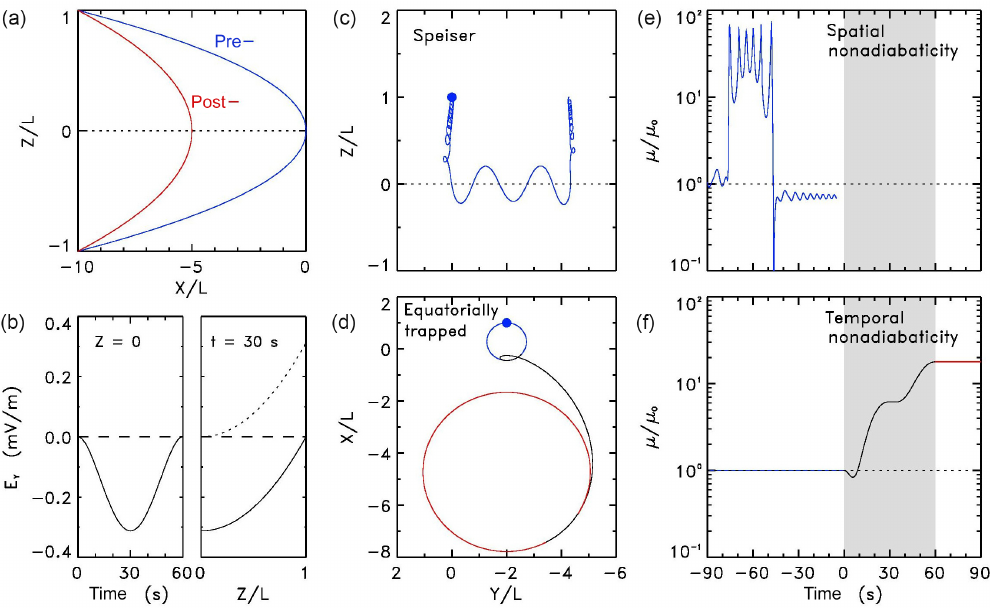
Figure 1. ( a ) Model magnetic field lines (Eq. 3) in the pre- and post-dipolarization configurations (coded in blue and red, respectively). ( b ) Total electric field ( E = − ∂ A /∂t +∇ (cid:56) ; solid line) at Z = 0 as a function of time and at t = 30s as a function of Z height. The dotted line shows the purely induced electric field E = − ∂ A /∂t . Model trajectory and magnetic moment versus time of ( c and e ) quasi-adiabatic H + and ( d and f ) equatorially trapped H + (blue and red relate to pre- and post-dipolarization configurations, respectively). A 60s magnetic transition (shaded area) is considered. Full circles show the initial H +